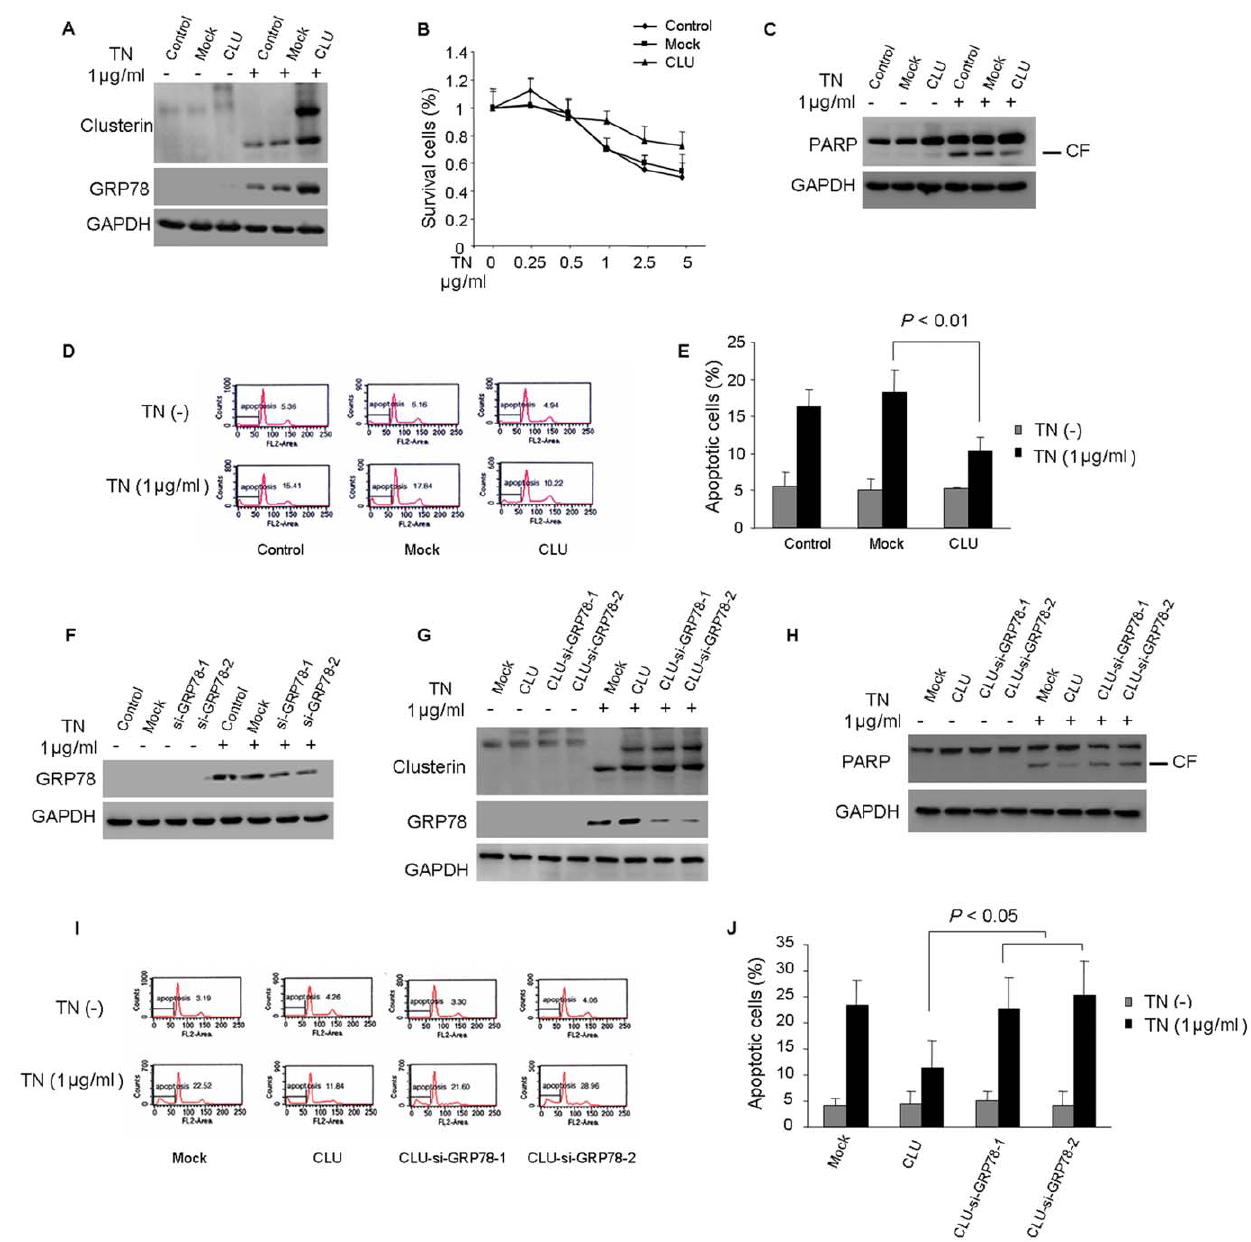
Figure 3. CLU induction following TN treatment is cytoprotective via increasing the expression of GRP78. (A) Control, mock and CLU- HepG2 cells were treated with 1 m g/ml of TN for 24 h. Protein extracts were analyzed for CLU, GRP78 and GAPDH. (B) CCK8 assay was performed to determine cell viability after TN treatment with indicated concentrations for 24 h. The values of relative survival rate were normalized with untreated cells. * P , 0.05, versus mock group. (C–E) TN-induced cell apoptosis in HepG2 cells were measured by Western blot analysis of PARP cleavage (CF, cleaved form) and flow cytometry (sub-G1). The results indicated that CLU played a protective role on HCC cells under ER stress condition. (F) HepG2 cells were transfected with scramble siRNA or siRNA specific for GRP78 followed by 1 m g/ml of TN treatment for 24 h. Protein extracts were analyzed for GRP78 and GAPDH. Knockdown of GRP78 expression in HepG2 inhibited TN induced GRP78 expression. (G) CLU overexpressed HepG2 cells were transfected with scramble siRNA or siRNA specific for GRP78 followed by 1 m g/ml of TN treatment for 24 h. Protein extracts were analyzed for CLU, GRP78 and GAPDH. (H–J) TN-induced cell apoptosis in HepG2 cells were measured by Western blot analysis of PARP cleavage (CF, cleaved form) and flow cytometry (sub-G1). The results suggested GRP78 may be important in mediating the protective effect of CLU under ER stress condition. All these data were from a representative experiment and the representative result was from at least three independent experiments. doi:10.1371/journal.pone.0055981.g003 number of apoptotic cells was significantly increased from 6/field staining ones. In addition, the effect of CLU on tumor cell in mock group to 22/field in CLU-shRNA group ( P , 0.01). Furthermore, we also found that down-regulation of CLU and apoptosis in vivo was examined through TUNEL staining (Figure 5B and C) and cleavage of PARP (Figure 5D). The